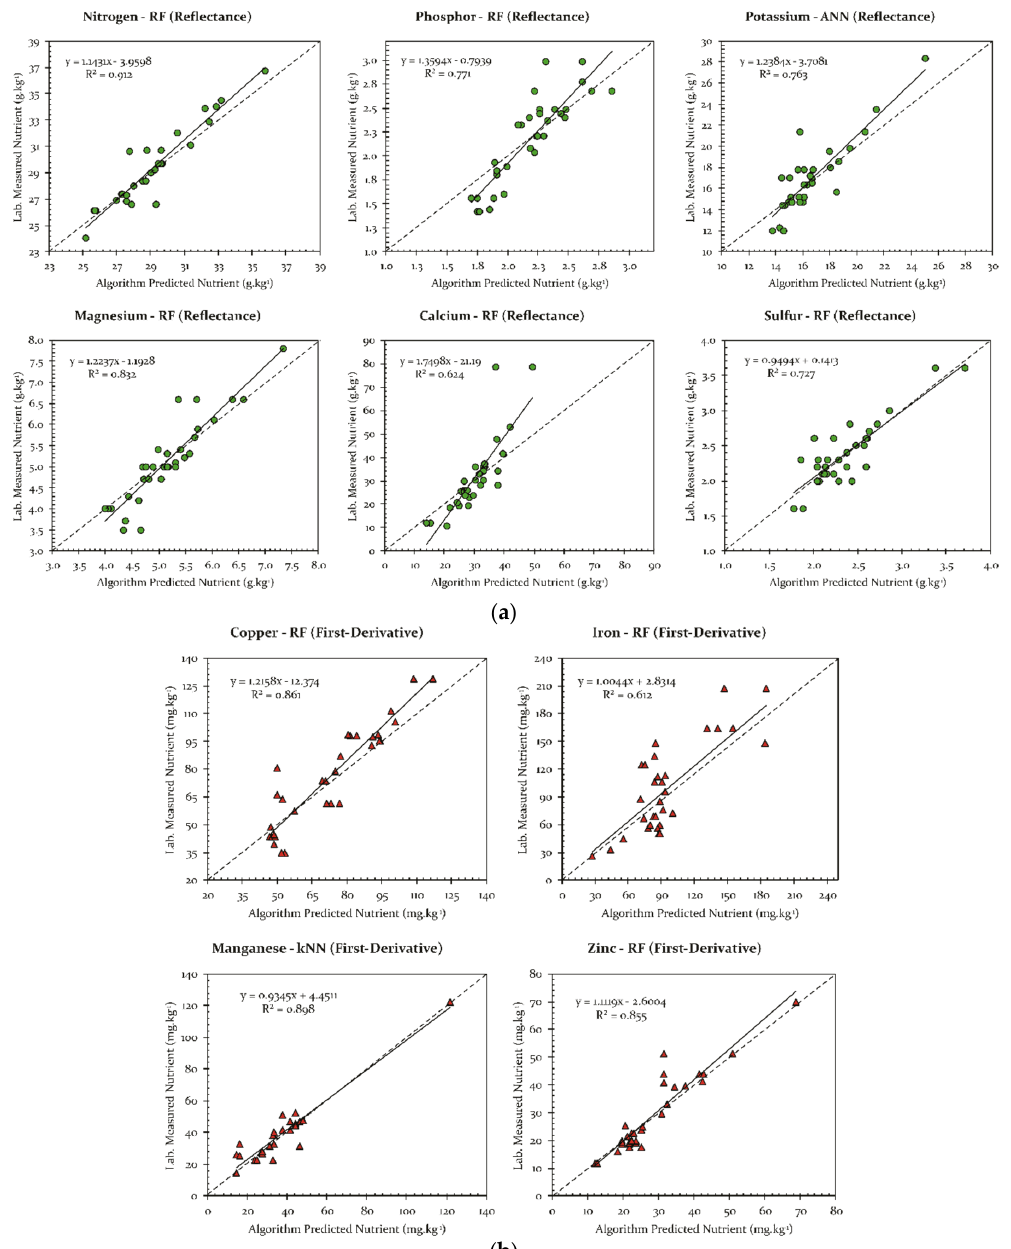
Figure 5. ( a ) Macronutrient prediction comparison against laboratory measurements for the best algorithms’ results. ( b ) Micronutrient prediction comparison against laboratory measurements for the best algorithms’ results.